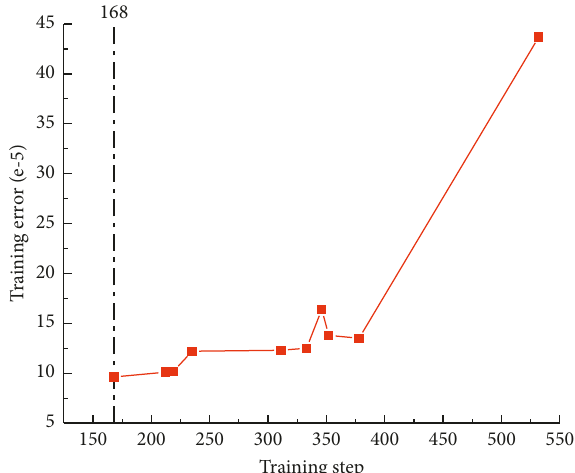
Figure 9: Mathematical relationship curve of two key variables of neural network